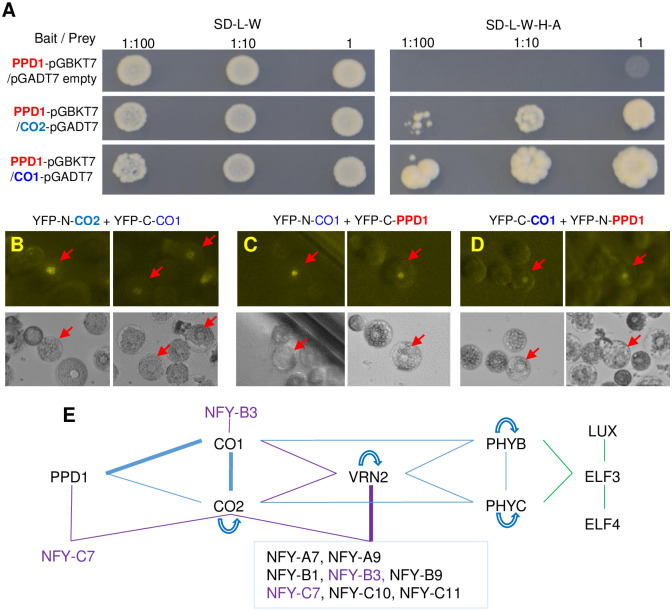
Protein interactions.(A) Yeast-two-hybrid (Y2H) interactions between PPD1 and CO1 or CO2. Left panel: SD medium lacking Leucine and Tryptophan (SD-L-W) to select for yeast transformants containing both bait and prey. Right panel: interaction on SD-L-W-H-A medium (no L, W, H (Histidine) and A (Adenine)). Dilution factors = 1, 1:10 and 1:100. (B-D) Split-YFP in wheat protoplast. (B) Positive nuclear interactions between CO1 and CO2. (C-D) Positive nuclear interactions between CO1 and PPD1 in two different YFP-N/YFP-C configurations. (E) Summary of Y2H interactions among wheat CO1, CO2, PPD1, VRN2, PHYB, PHYC, and ELF3 from S5 Fig. Green lines are based on published results from Brachypodium [35] and violet lines on published results from wheat [24]. Thick lines indicate interactions validated by split-YFP in wheat protoplasts (blue) or in vitro coIP (violet). Curved arrows indicate self-dimerization.